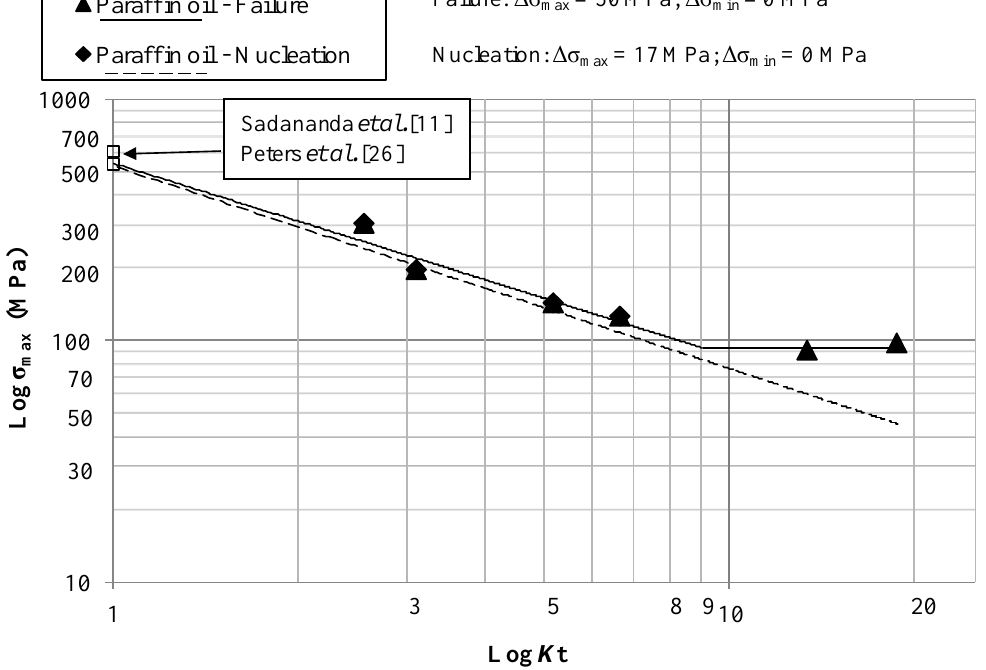
Figure 12. Log-limiting maximum stress ( R = 0.1, 10 Hz) at initiation and failure vs. Log- K a constant life of 200,000 cycles for the samples tested in Paraffin